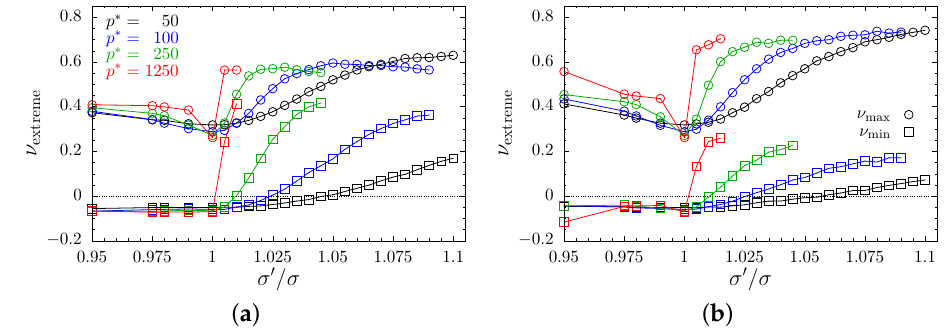
Figure 10. Extreme PR values for systems with ( a ) D -type and ( b ) S -type separate nanochannels, plotted with respect to scaling factor σ (cid:48) / σ . Values for maximal and minimal PR are marked with sphere and square symbols, respectively. Results obtained for different values of the reduced external pressure p ∗ have been indicated in colors.